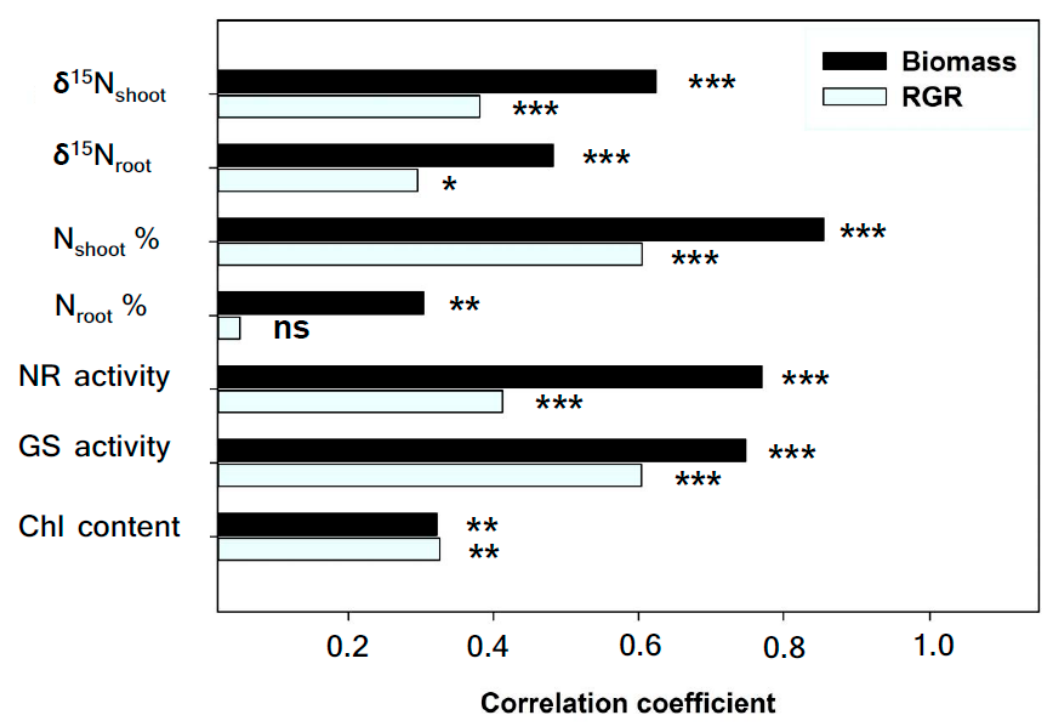
Figure 3. Correlation coe ffi cients of the nitrogen stable isotope composition ( δ 15 N) and N concentration of dry matter in shoots and roots, nitrate reductase activity (NR), glutamine synthesis activity (GS) and chlorophyll content (Chl) in leaves with total shoot biomass and relative growth rate (RGR) across treatments and genotypes. Levels of significant are as follows: ns, not significant; * p < 0.05; ** p < 0.01 and *** p < 0.001. n =